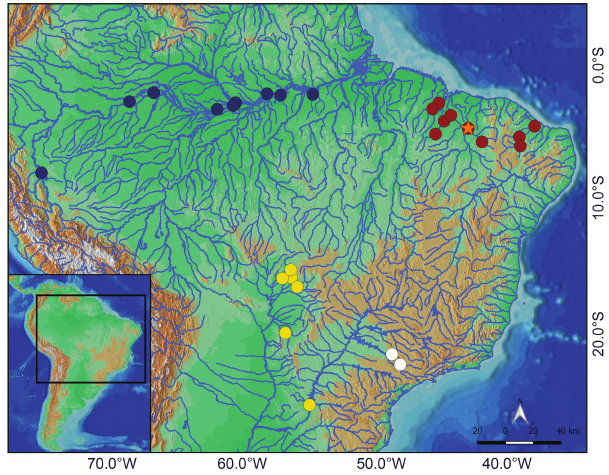
Fig. 4 . Location of the lots containing the studied species: Schizodon dissimilis (red, orange star marks the type- locality), S. fasciatus (dark blue) , S. borellii (yellow) and S. intermedius (white); each symbol may represent more than one